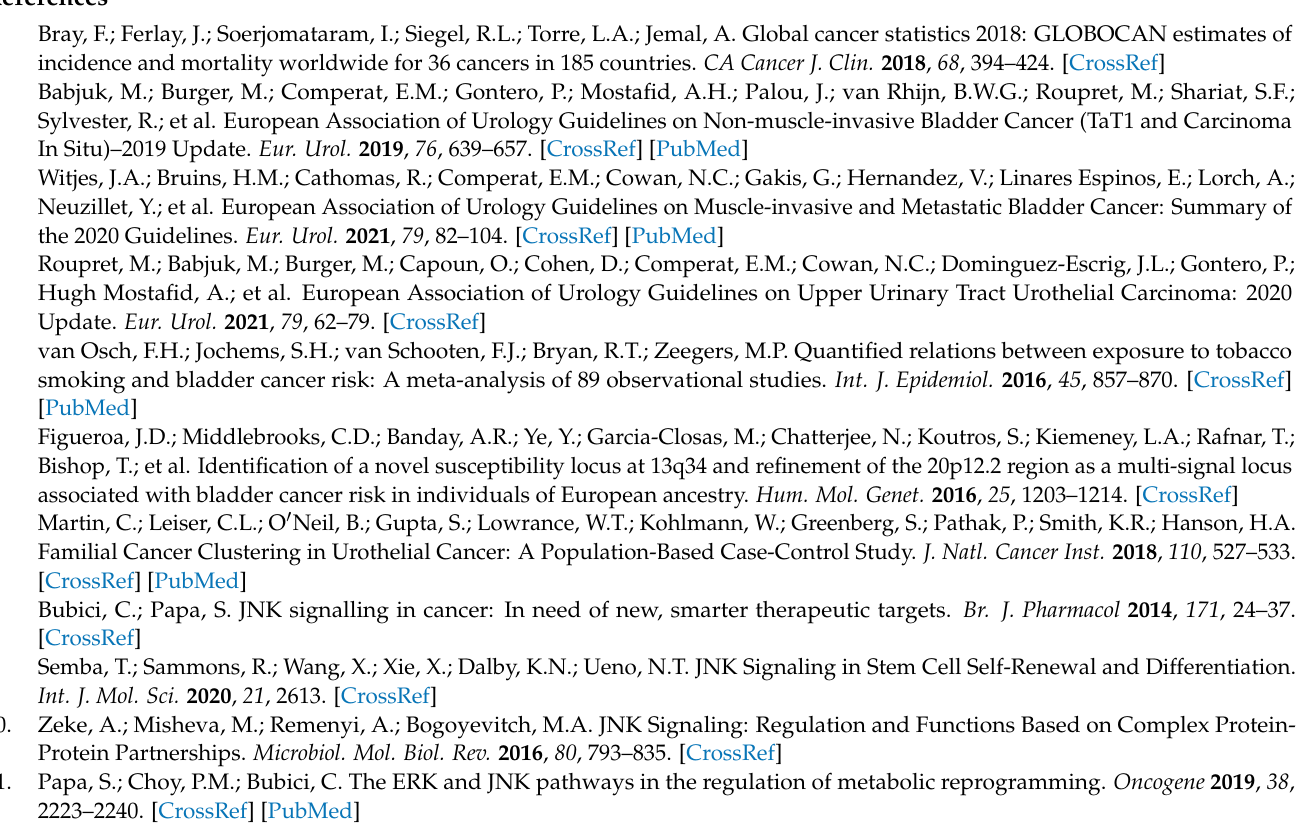
Table S2: The top 500 most significant differentially expressed genes that are positively correlated with ROR2 expression in bladder cancer. Table S3: The top 500 most significant differentially expressed genes that are negatively correlated with ROR2 expression in bladder cancer. Table S4: GO enrichments of positively associated genes. Table S5: GO enrichments of negatively associated genes. Figure S1: Kaplan–Meier analysis of overall survival according to MAPK10 , MINK1 , MAP4K3 , CDC42EP5 , and PAK1 expression in UC patients. Figure S2: Kaplan–Meier analysis of overall survival according to JNKs expression in UC